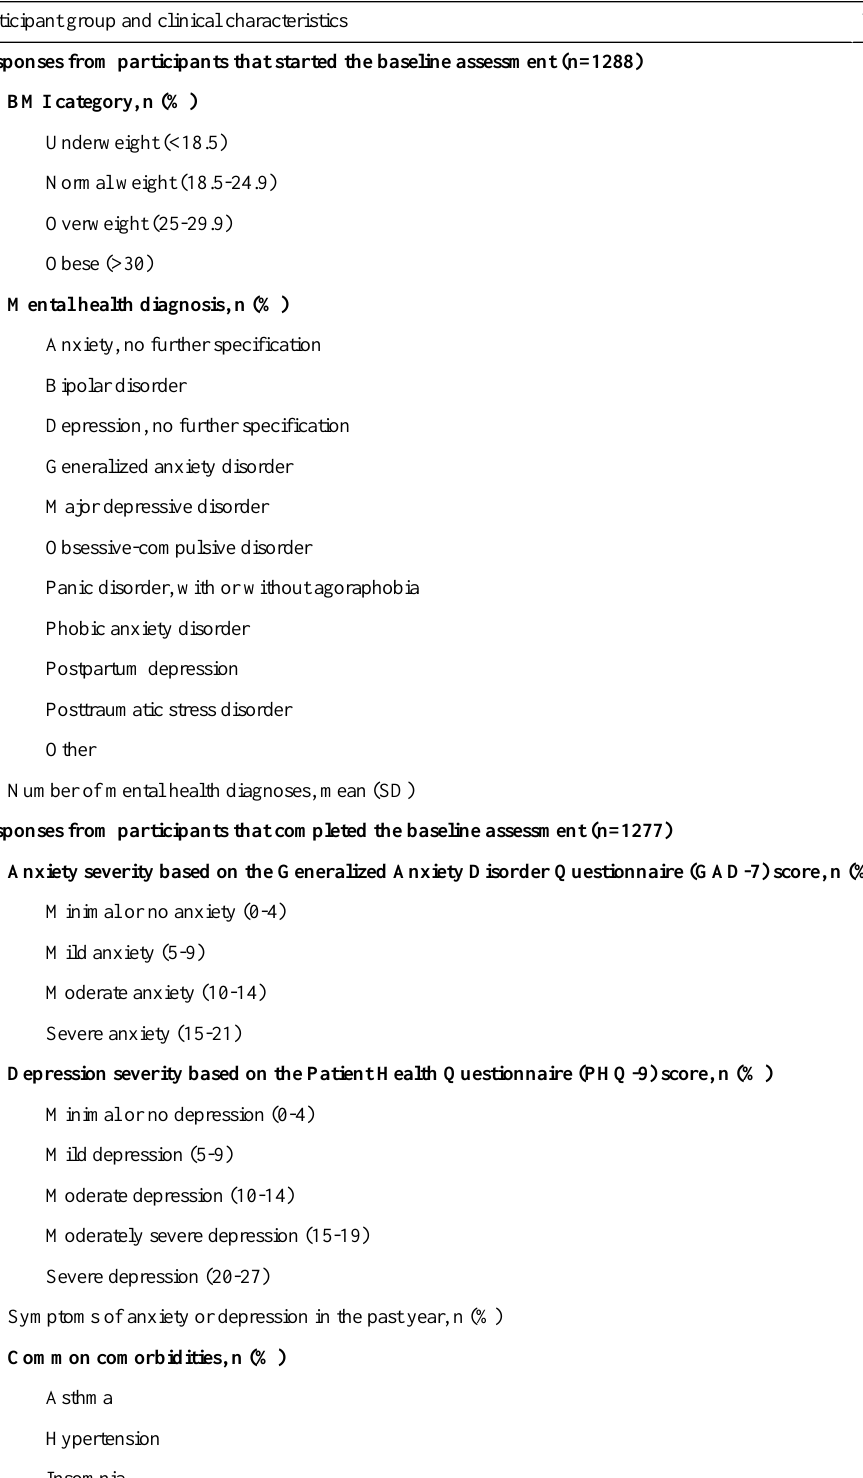
Table 3. Clinical characteristics of enrolled